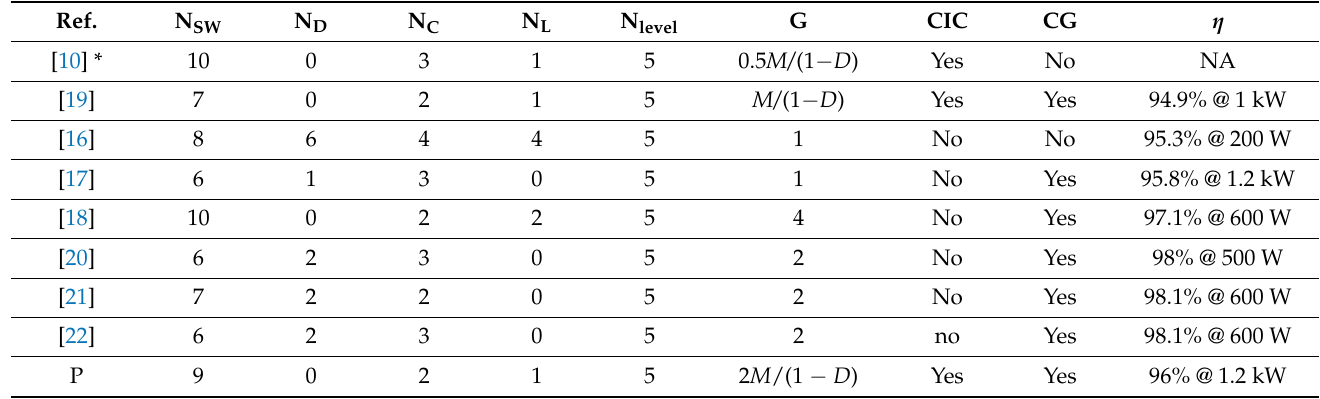
Table 2. Comparative study of the proposed inverter with its counterpart topologies.